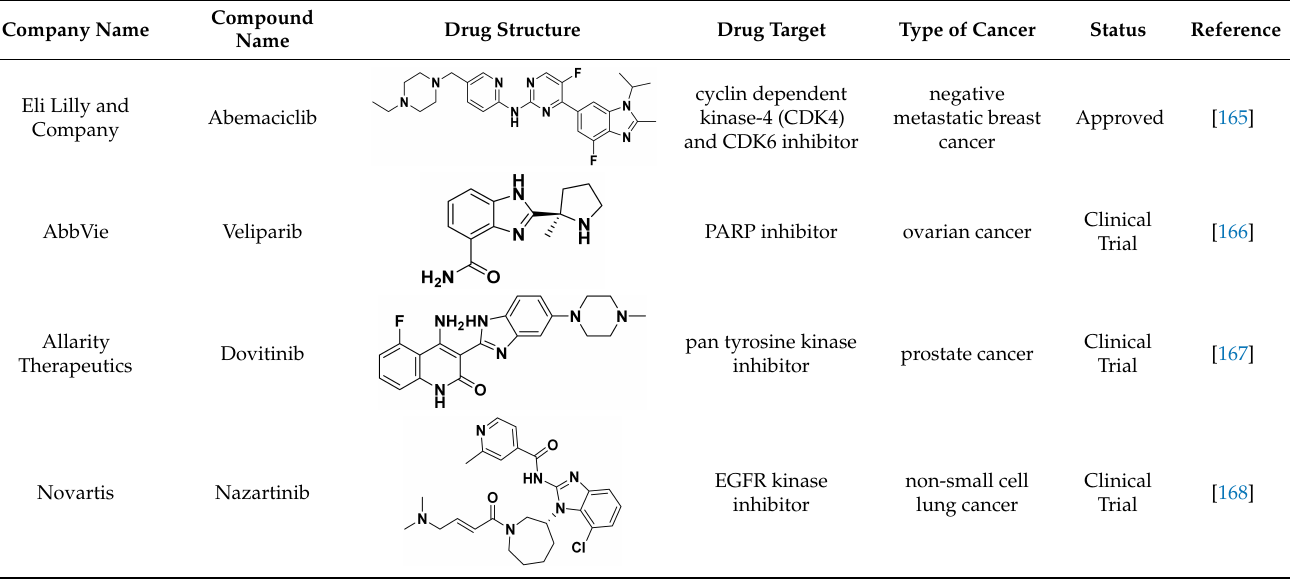
Table 81. Current status of benzimidazole based hybrids that are approved or under clinical